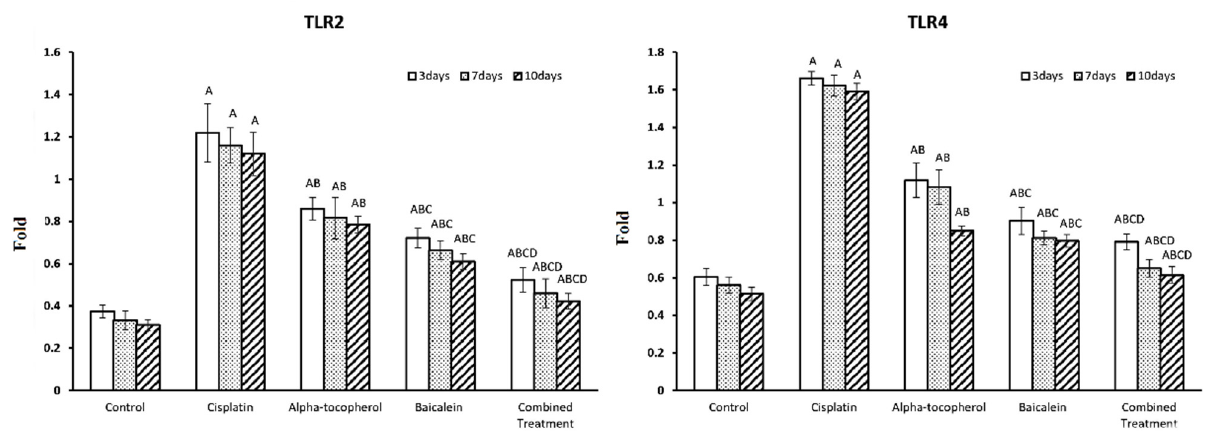
Figure 5. Effect of α -tocopherol and baicalein administration on TLR2 and TLR4 in control and treated groups. All data are expressed as mean ± SEM. Significant vs. control group refers to A, while significant vs. (cisplatin, -tocopherol, and baicalein) treatment groups refers to (B, C, D), re- spectively.